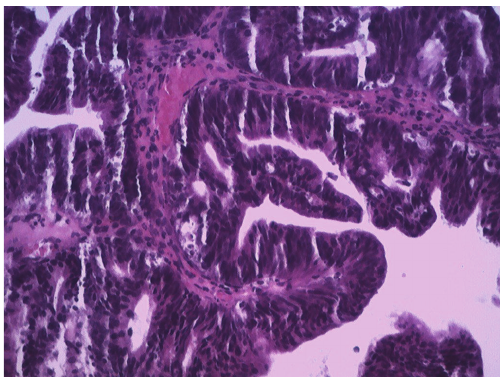
Figure 3: Invasive moderately differentiated mucinous adenocarci- noma endocervical type composed of irregular and anastomosing glands with papillary